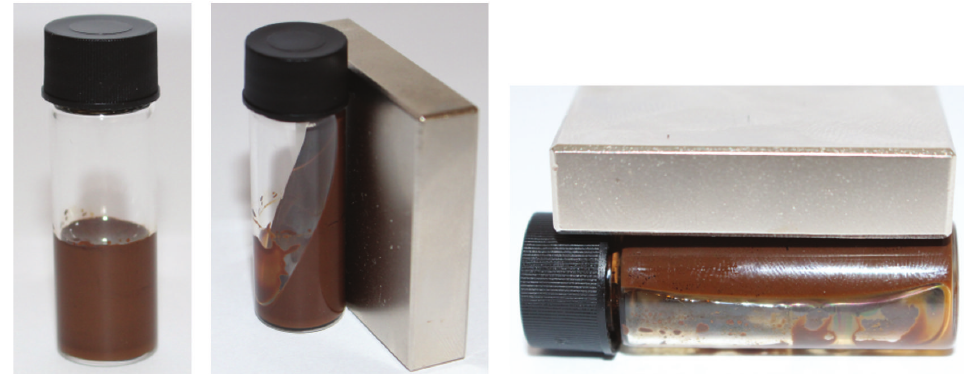
Figure 9: The effect of a magnetic field on a magnetite-stabilized emulsion.